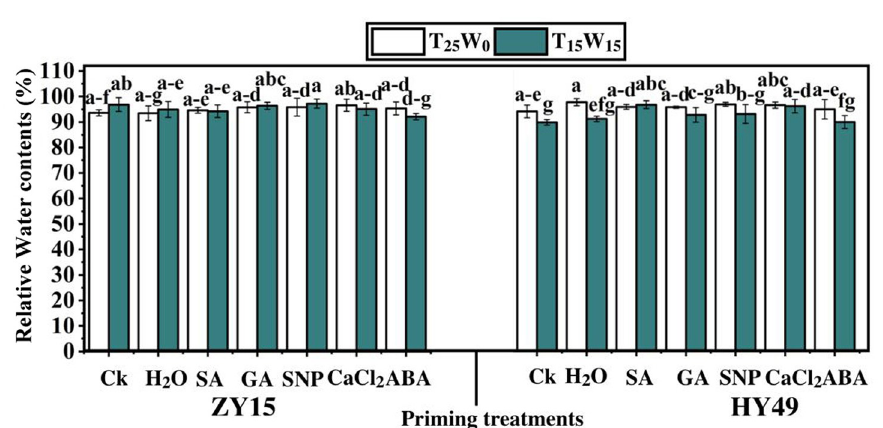
Fig 3. Effects of low temperature and drought stresses (25˚C and 0 MPa, 15˚C and -0.15 MPa) on the relative water contents of Brassica napus seedlings (varieties ZY15 and HY49). Seven different treatments ( a ) control (Ck), ( b ) water (H 2 O), ( c ) salicylic acid (SA), ( d ) gibberellic acid (GA), ( e ) sodium nitroprusside (SNP), ( f ) calcium chloride (CaCl 2 ), and ( g ) abscisic acid (ABA) were evaluated. Each point represents the mean of three replicates. The values presented are the mean ± standard deviation (SD). Significant differences among treatments were determined by a three-way analysis of variance (ANOVA) (p < 0.05 according to Duncan’s multiple range tests).